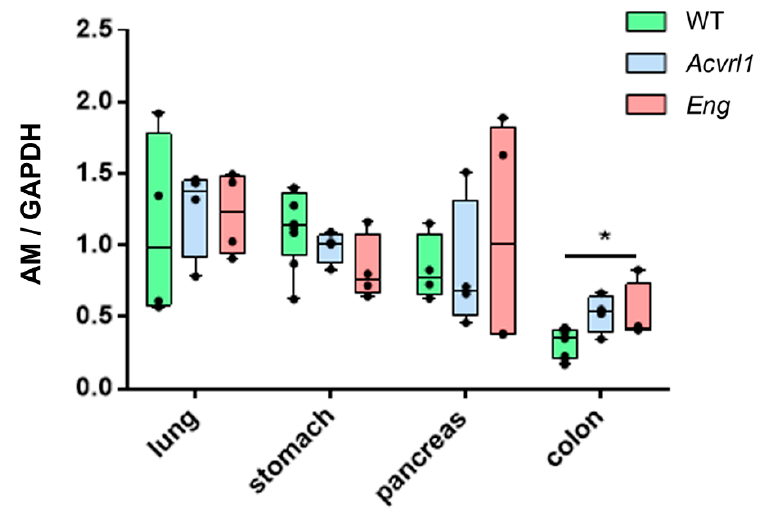
Figure 3. AM expression in endoderm-derived organs as measured by qRT-PCR. No differences were found among genotypes in the lungs, stomach, or pancreas. Box plots represent the interquartile range with the median as a horizontal line. Whiskers encompass the maximum and minimum values of the population. Dots represent individual animals. *: p < 0.05.